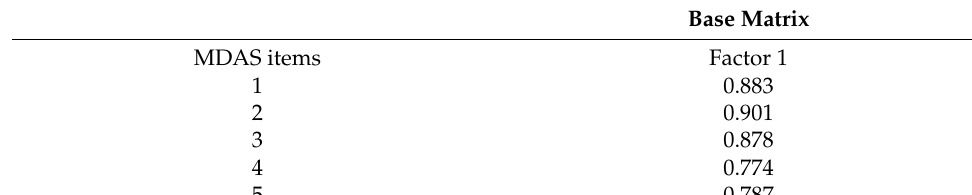
Table 2. Exploratory Factor Analyses of the Hebrew Version of MDAS Factor Loadings (Study 1).